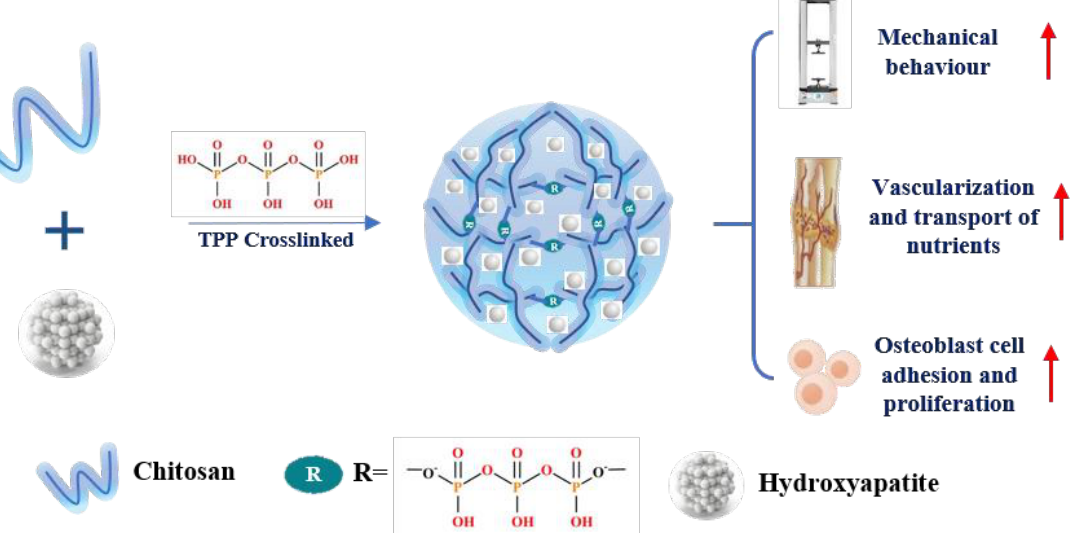
Figure 4. Scheme of developing and characterizing the microparticles of nano-hydroxyapatite, chitosan, and tripolyphosphate.